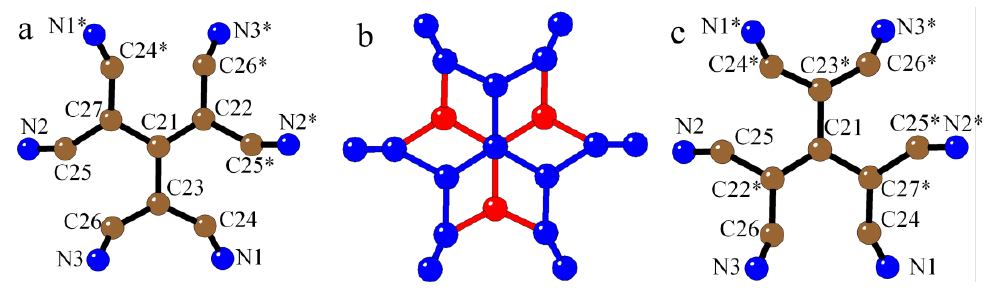
Figure 2. View of the statistical disorder of the tcpd 2− anion in compound 1 (similar in 2 ). Symmetry operation: * = −x, −y, −z.